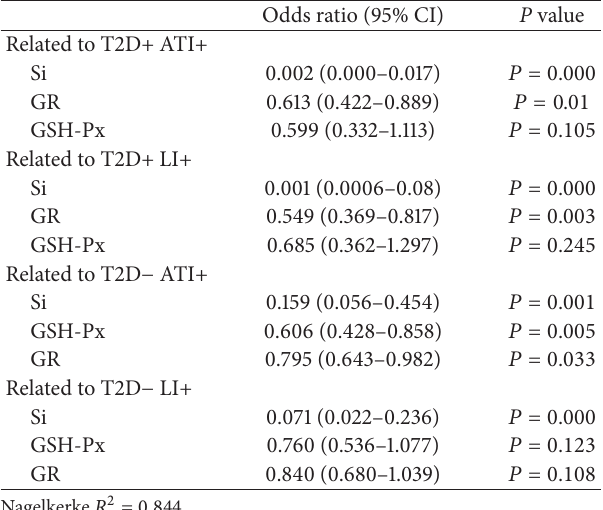
Table2:Independentfactorsrelatedtodifferentsubtypesofischem- ic stroke in diabetics and nondiabetics in multiple logistic regression analysis.